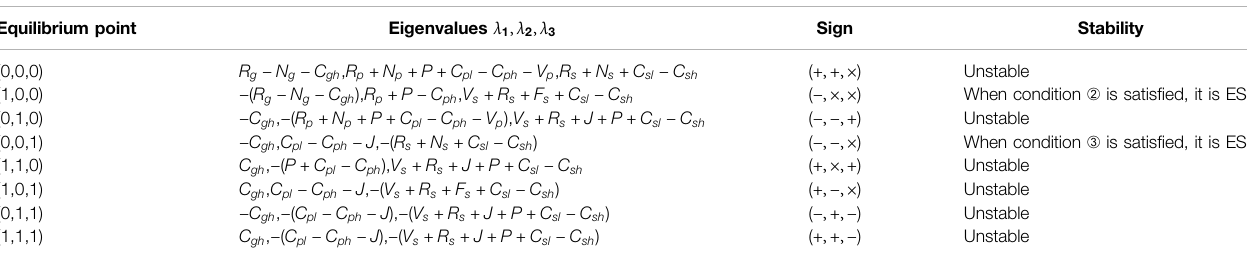
TABLE 4 | Stability analysis when consumer chooses no complaint. Equilibrium